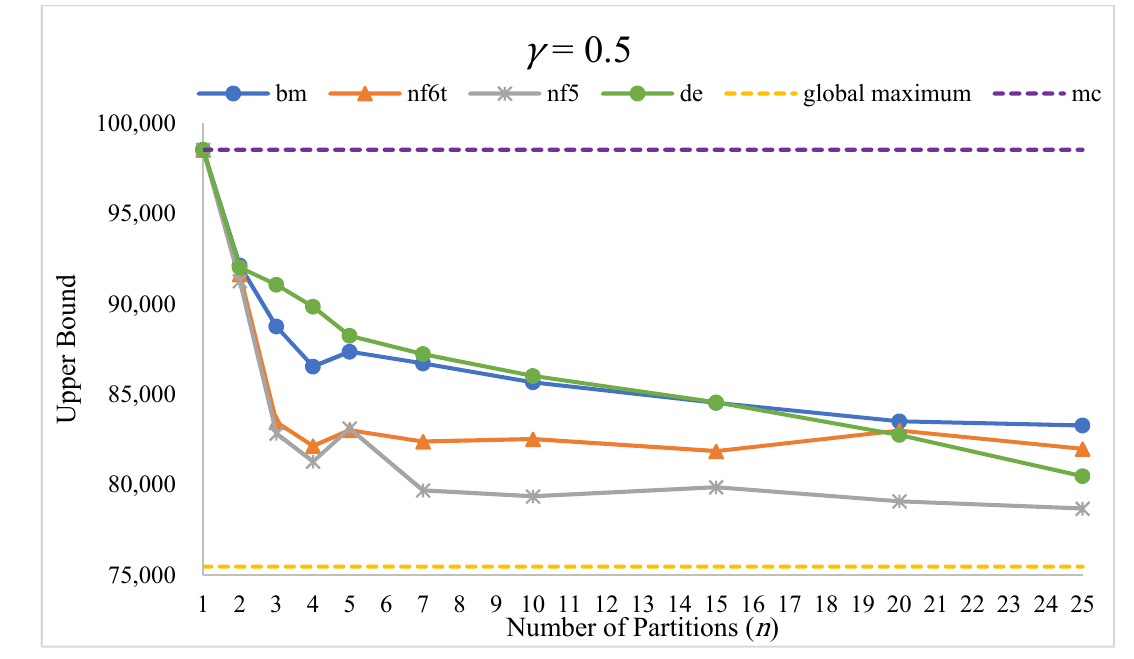
Figure 4. Convergence-indicating curves of the bm , de , nf5 , and nf6t relaxation schemes for 𝛾 = 0.25.